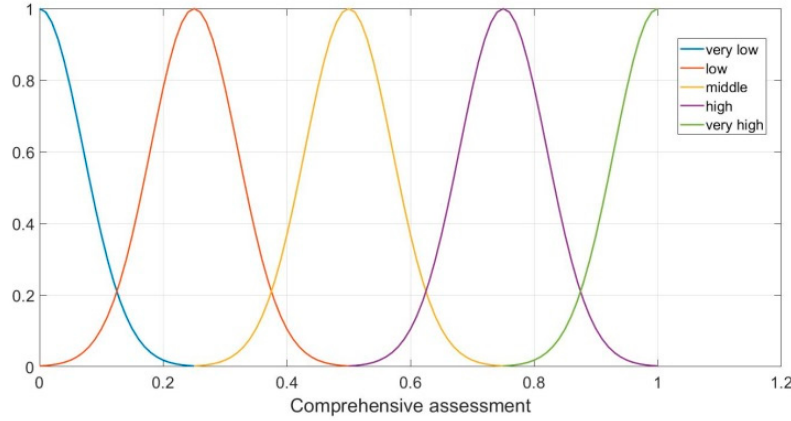
Figure 6. Subordinating degree function of parameter E .